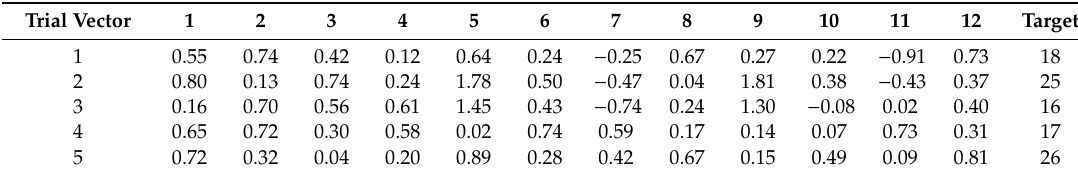
Table 12. Trial vectors of round 1.